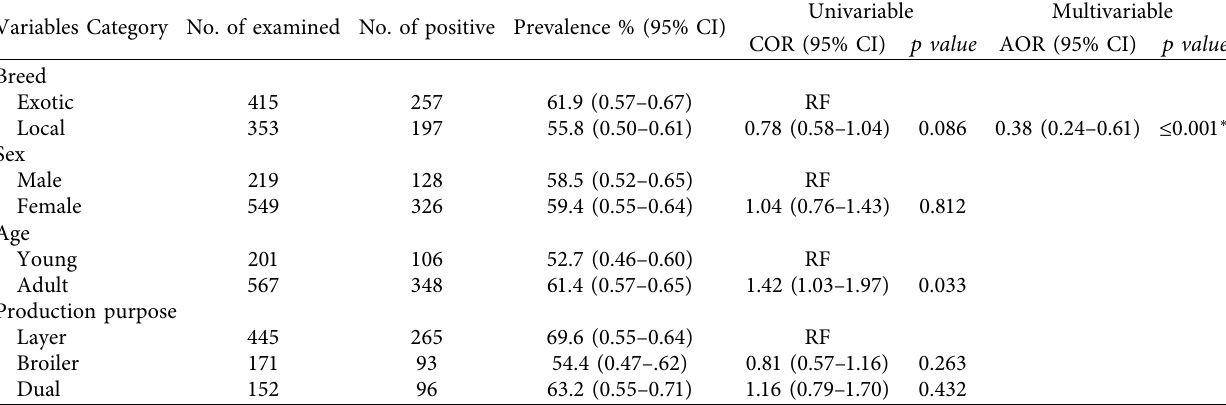
Table 3: Univariable and multivariable mixed-effect logistic regression analysis of host-related risk factors with ILTV seroprevalence. Variables Category No. of examined No. of positive Prevalence % (95% CI)